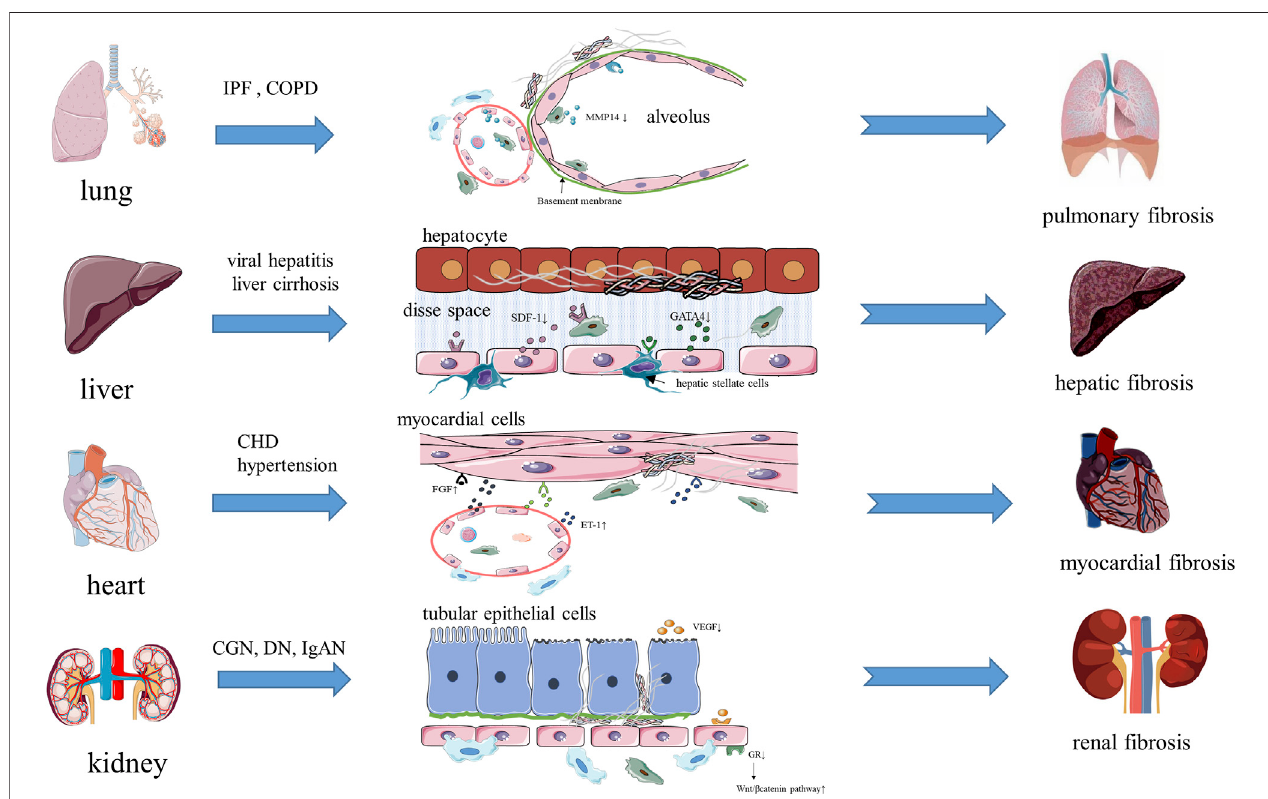
FIGURE 2 | The vascular niche and organ fi